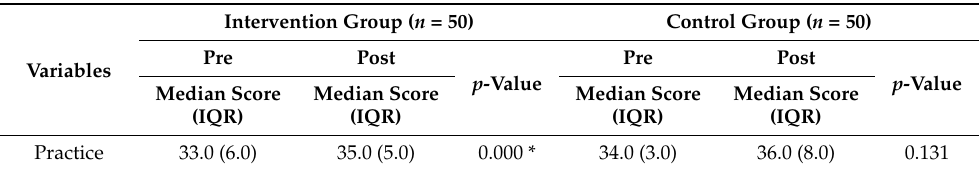
Table 5. Food poisoning preventive practice score before and after intervention among respondents ( n =